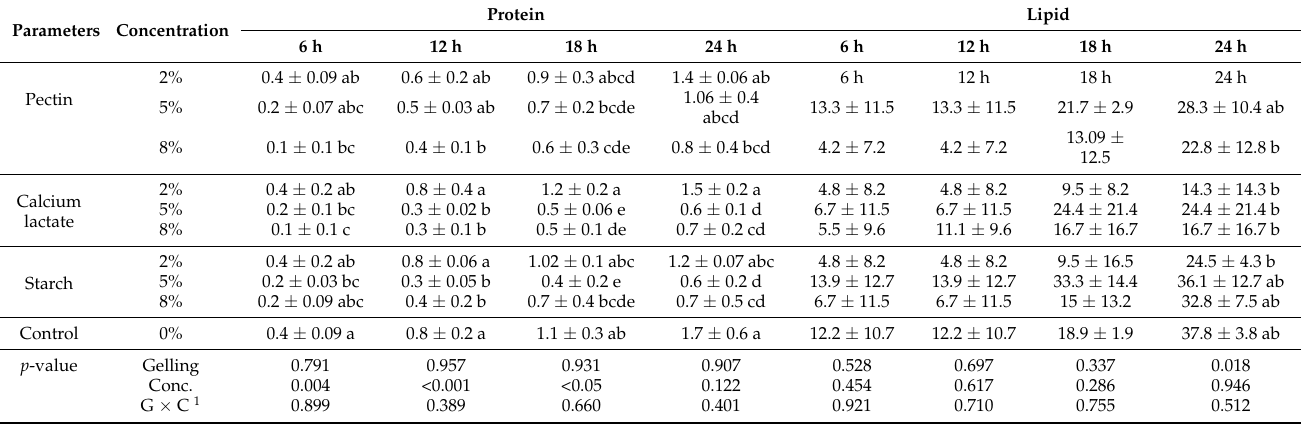
Table 3. Nutrient leaching of different gel-based